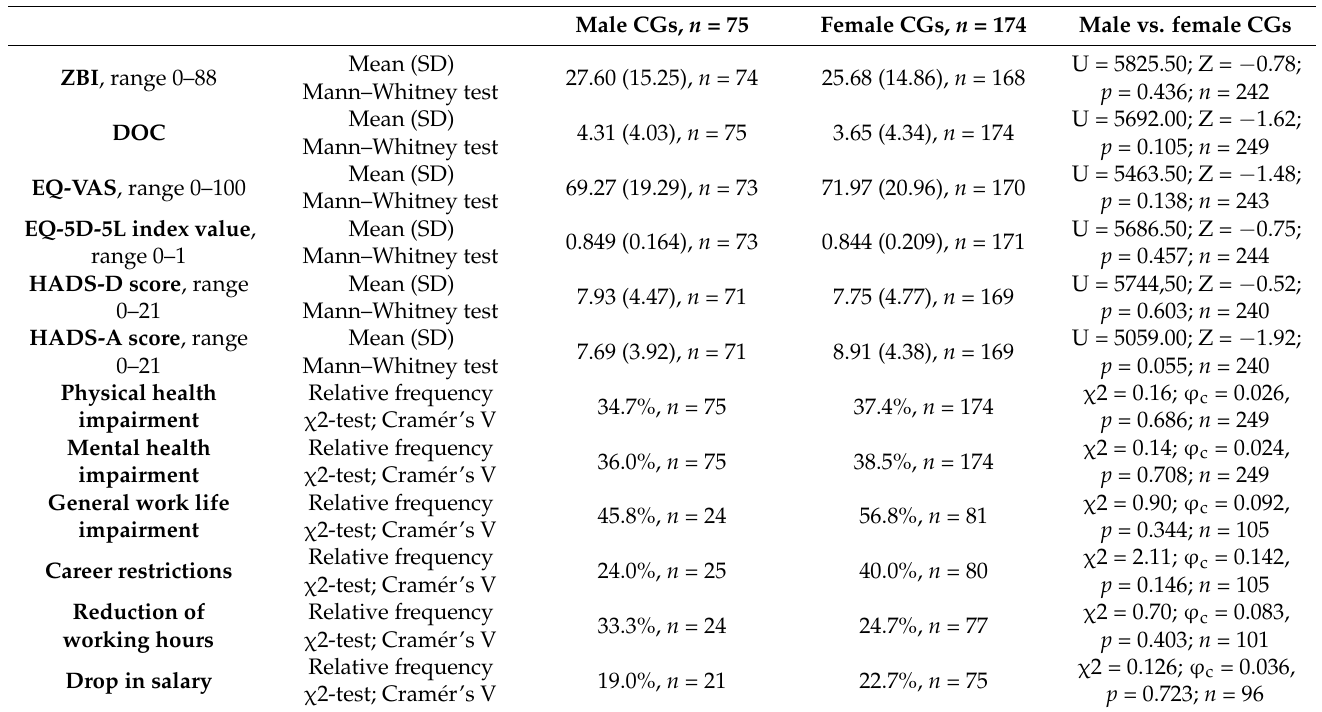
Table 6. Effect comparison between men and women: Besides the difference in anxiety, no statistical differences were found. Abbreviations: CGs = caregivers; n = number; ZBI = Zarit Burden Interview; SD = standard deviation; DOC = duration of caregiving; EQ-VAS = EuroQol visual analog scale; HADS-D = Hospital Anxiety and Depression Scale-depression subscale; HADS-A = Hospital Anxiety and Depression Scale-anxiety